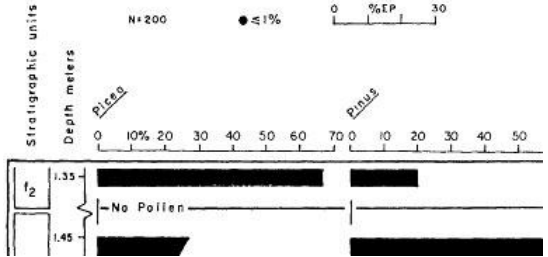
Figure 2: Example of a palynological dataset represented using a tabular form (King 1973, fig.10)